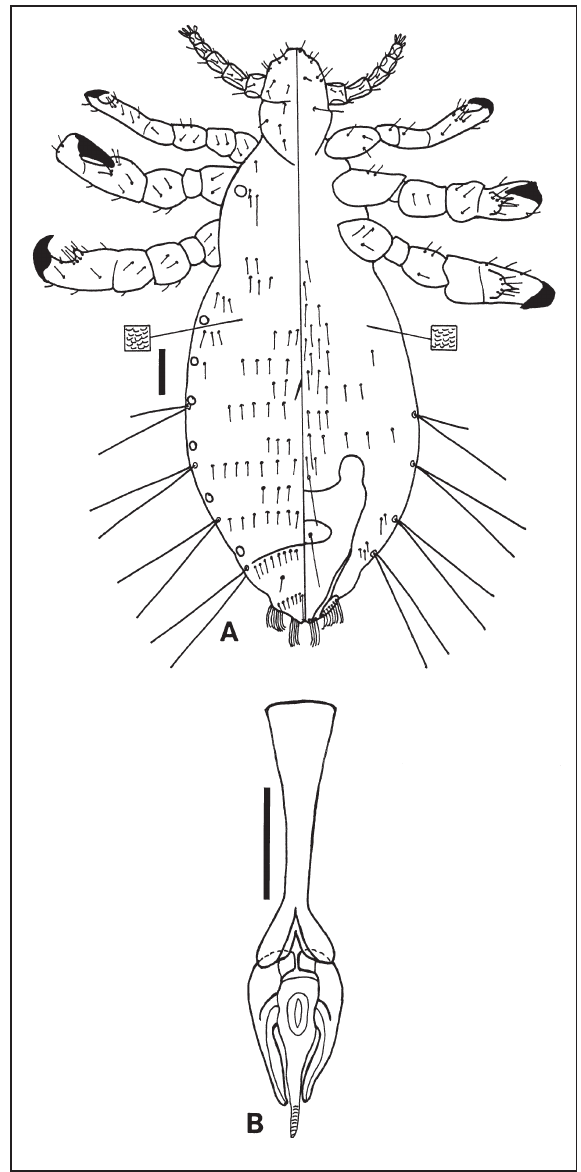
FIG. 1 Linognathus weisseri , n. sp., male. A. Dorso-ventral view. B. Genitalia. Both scale bars = 0.1